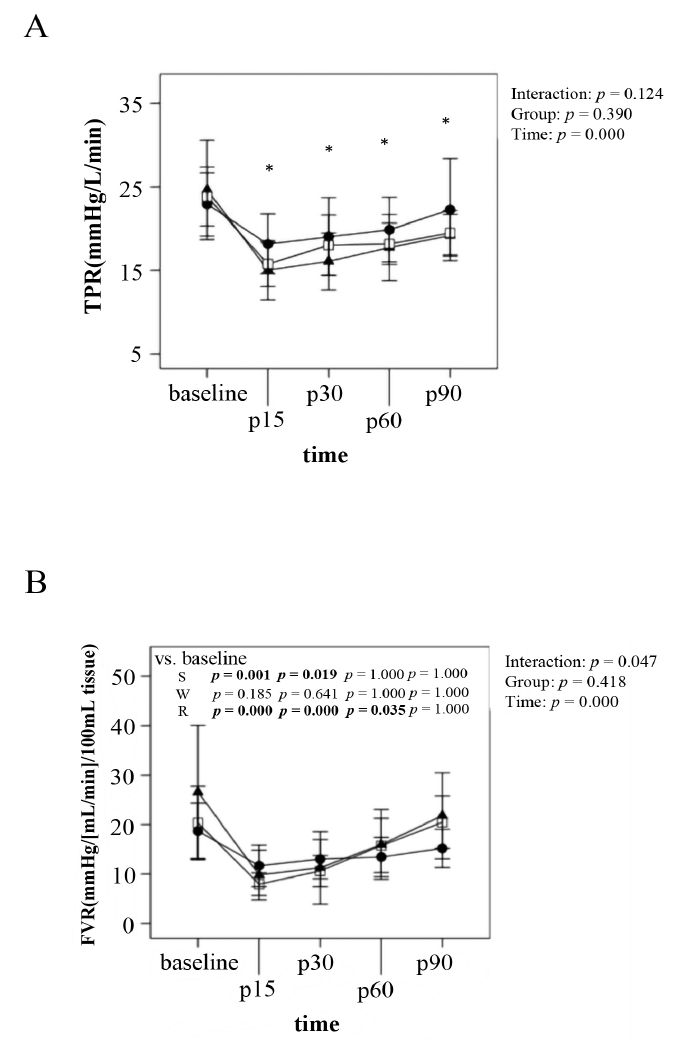
Fig. 3. Total peripheral resistance (TPR) and forearm vascular resistance (FVR) before and after exercise. Data are presented as means ± standard deviations. □ , Sedentary controls (S); • , Weightlifters (W); and ▲ , Runners (R). p15, p30, p60, and p90; 15, 30, 60, and 90 min after exercise,